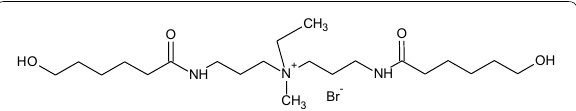
Fig. 1 Chemical structure of QAS used for membrane